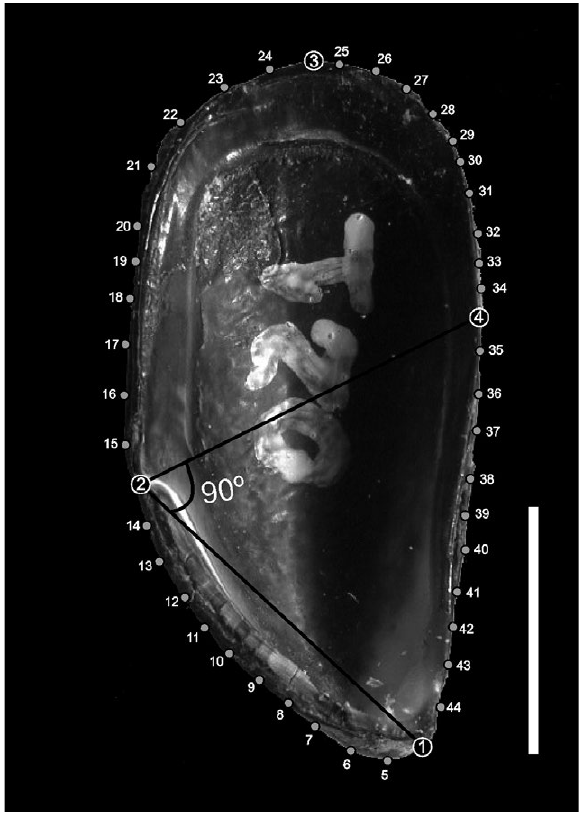
Fig. 2. – Landmark (black dots) and semi-landmark (grey dots) con- figuration to capture the outline shell shape of the scorched mussels Perumytilus purpuratus . Scale bar = 1